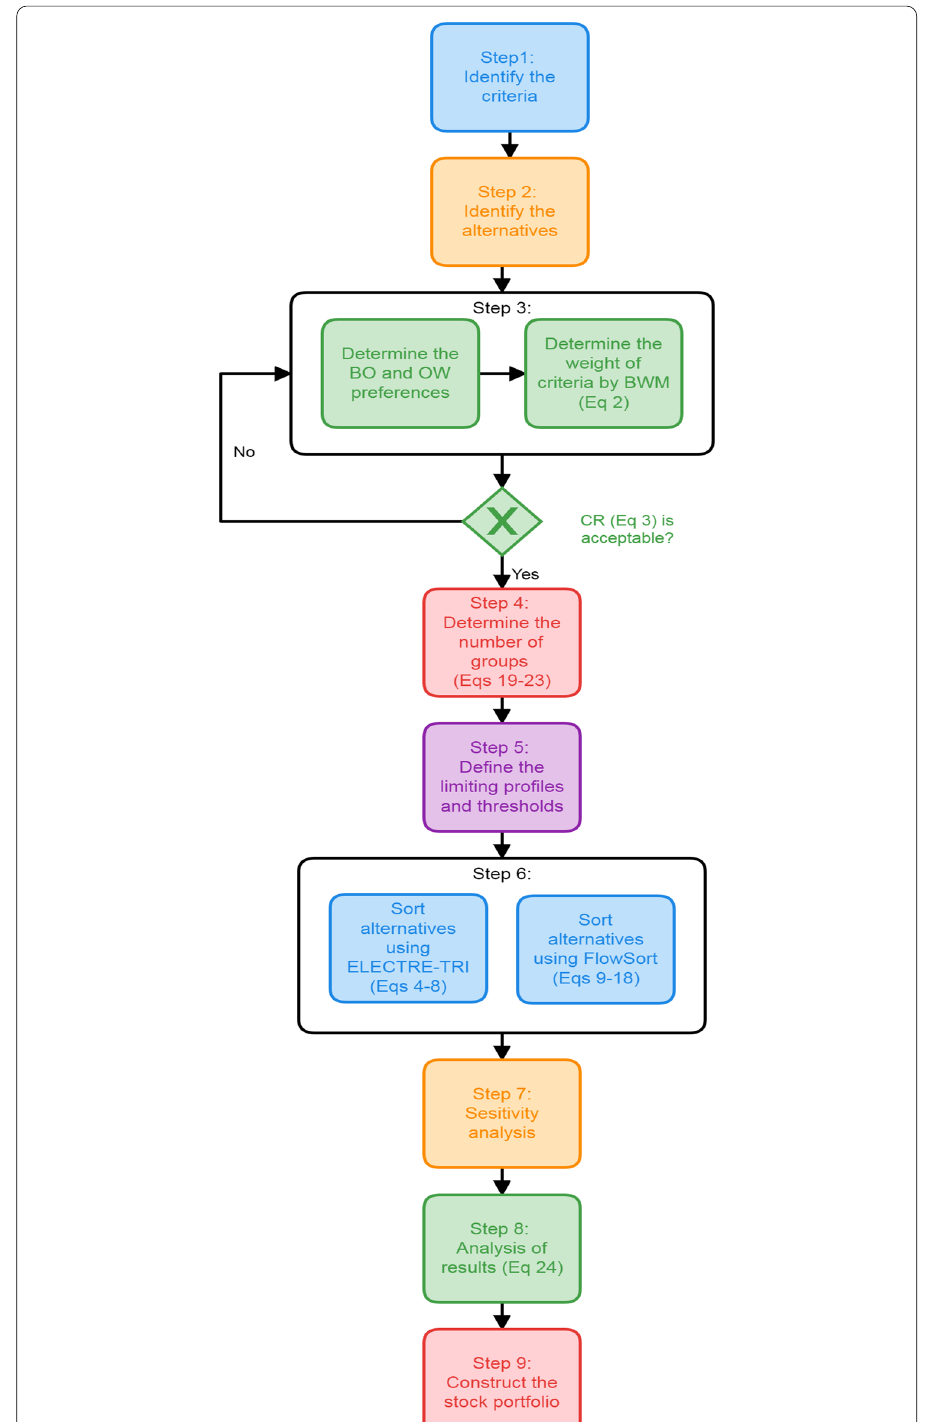
Fig. 1 Flow diagram of the research